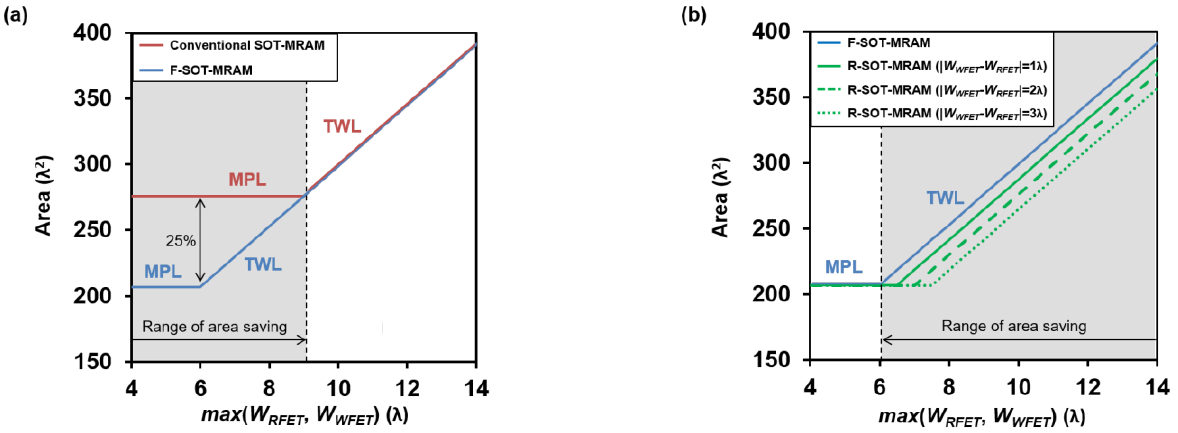
Figure 6. ( a ) Bit-cell area comparison between conventional SOT-MRAM and F-SOT-MRAM; ( b ) bit-cell area comparison between F-SOT-MRAM and R-SOT-MRAM. Bit-cell area is metal pitch limited (MPL) or transistor width limited (TWL).